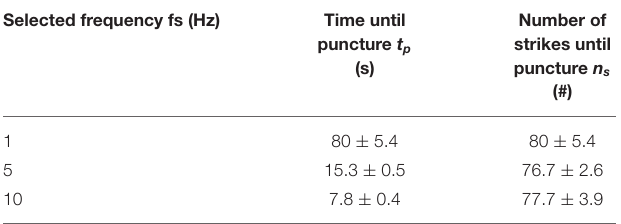
TABLE 6 | Experimental results (mean ± standard deviation, n = 3) of the proof-of-principle experiment. Selected frequency fs (Hz) Time until